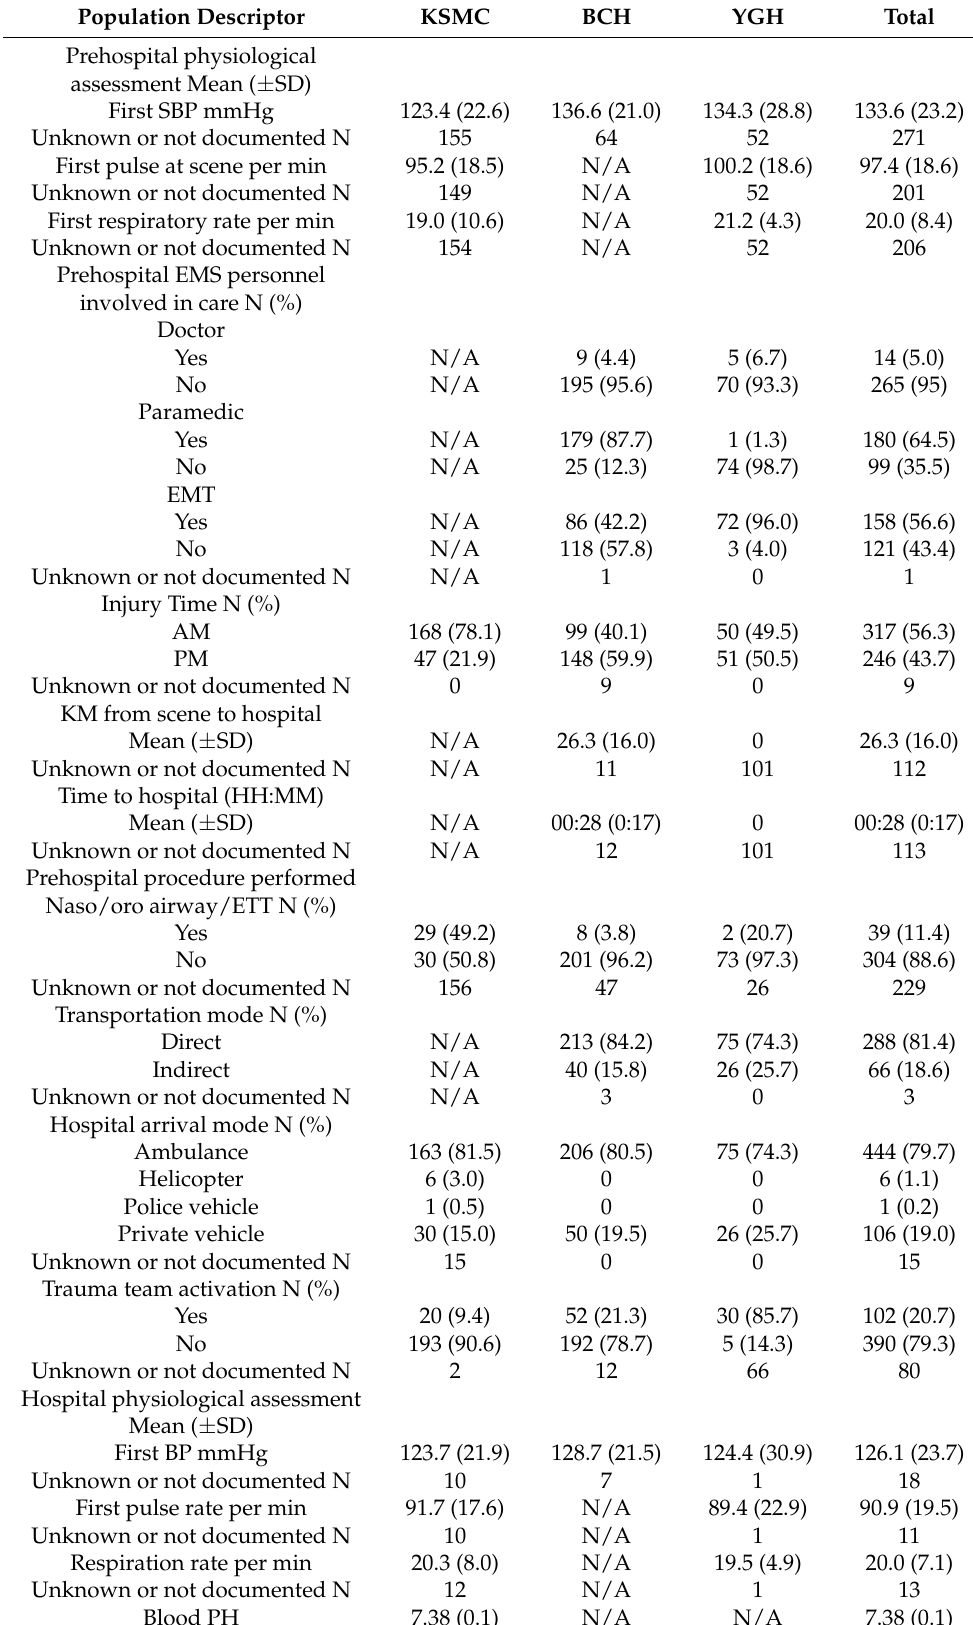
Table 3. Prehospital and hospital